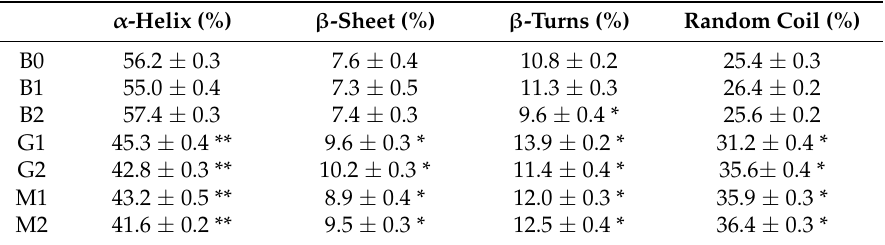
Table 1. Secondary structure composition of BSA, BSA–glucose and BSA–mannose at intensities 10 and 20 kV/cm. α -Helix